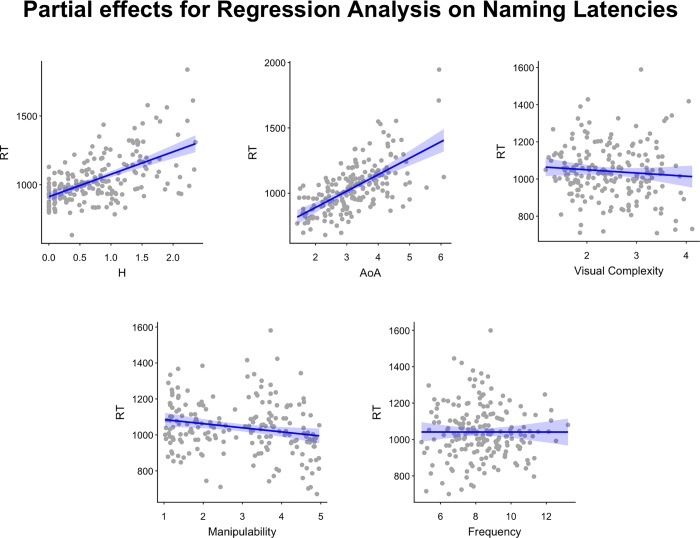
The figure shows the partial effects for the regression model on Naming Latencies.Each panel represents the partial effect of a predictor included in the regression. The blue lines represent the regression for that partial effect. The shaded blue represents the area delimiting the standard error of the estimate. The gray points indicate the partial residuals associated with the predictor.